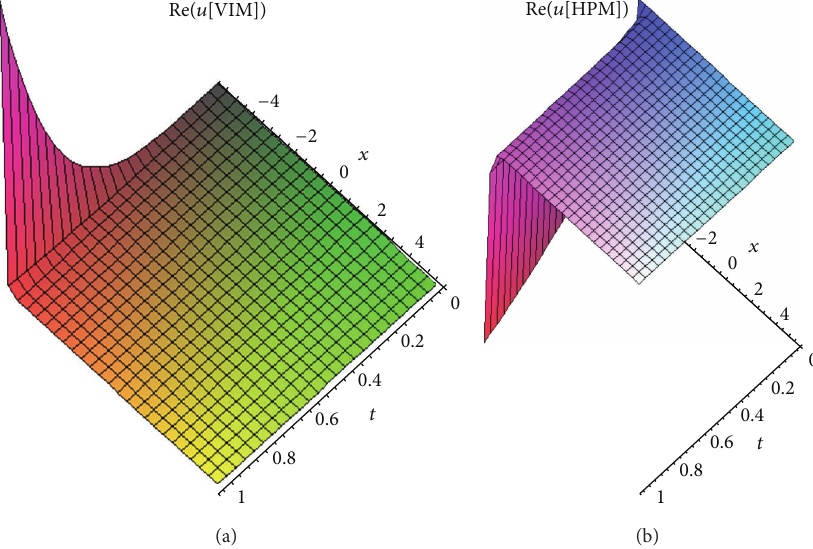
Figure 2: The real part of the approximate solution obtained by the variational itearation method (38) shown in (a) in comparison with the of that approximate solutions obtained by homotopy perturbation method (32) shown in (b) when 𝛼 = 0.2 , 𝛽 = 0.4 , −5 < 𝑥 < 5 , and 0 < 𝑡 < 1 .